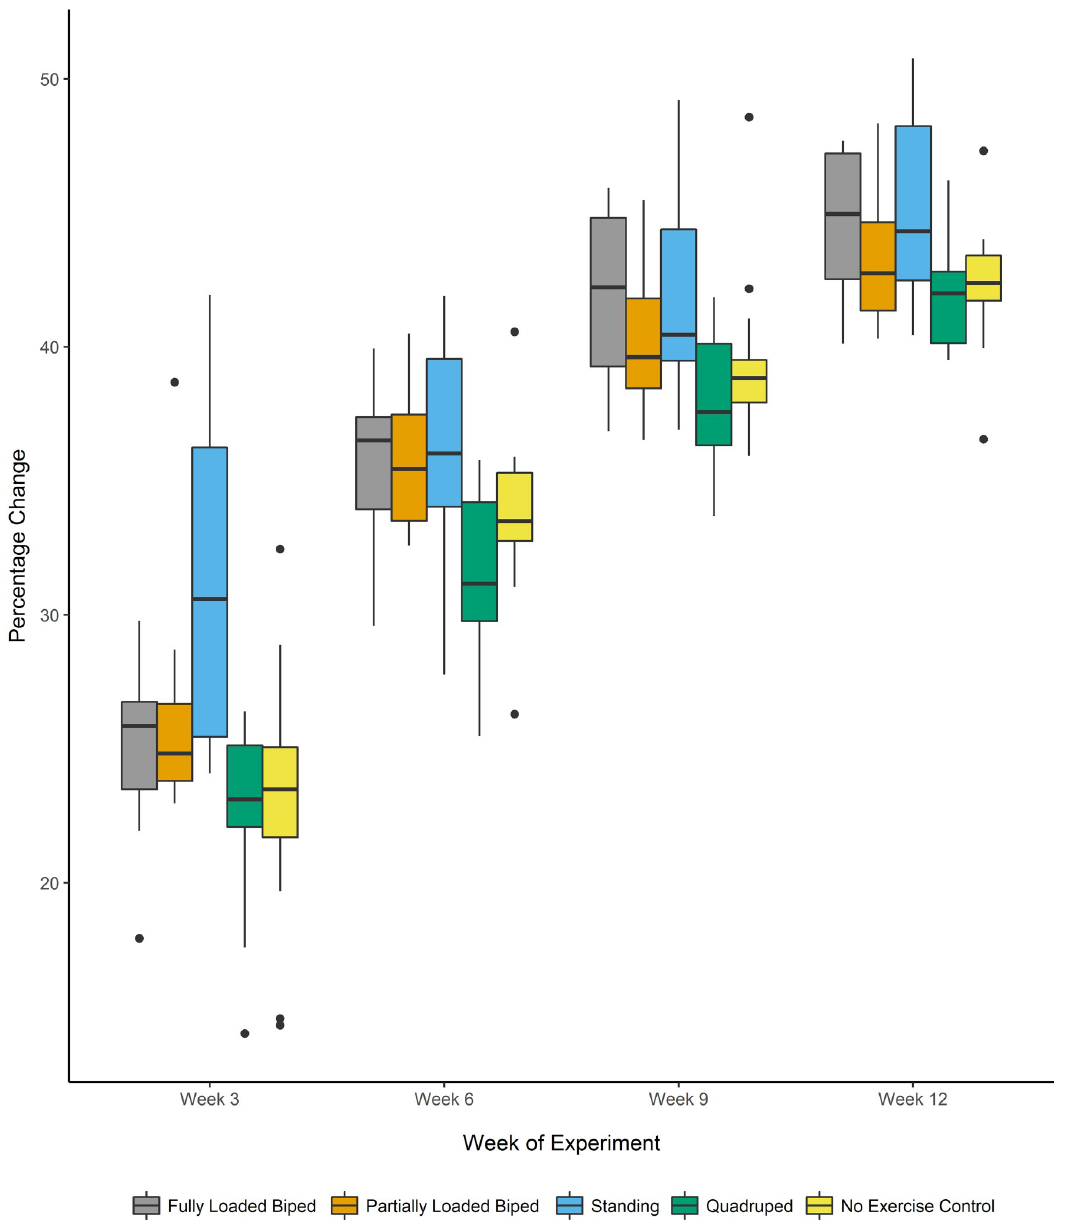
Fig 4. Percentage change in femur length over the 12-week experiment. Boxplot of the percentage change in femur length at weeks 3, 6, 9, and 12 relative to the length at the beginning of the experiment. The horizontal lines indicate the median, the outer boundaries of the box represent the interquartile range, the whiskers indicate the minimum and maximum, respectively, and the individual points represent outliers.